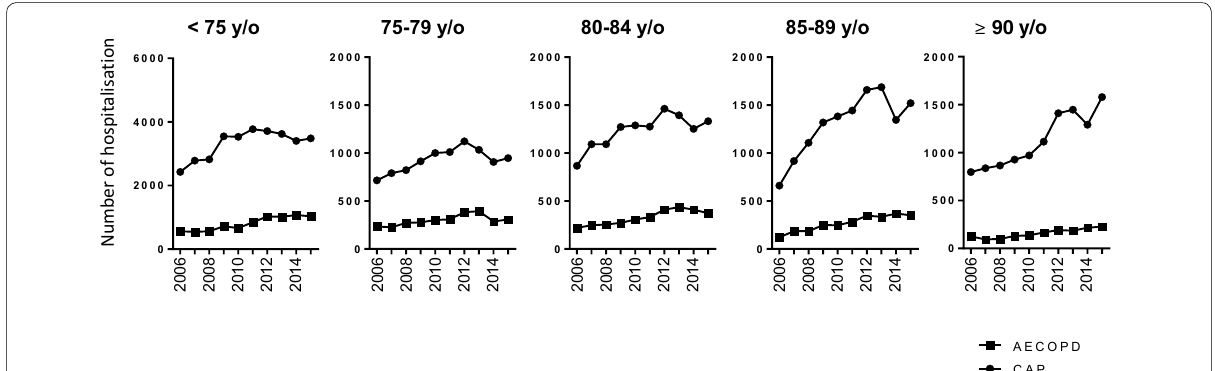
Fig. 3 Ten‑year trends in hospitalisation for CAP and AECOPD by age class. All increases in CAP and AECOPD hospitalisations over time from 2006 to 2015 were statistically significant. AECOPD acute exacerbation of chronic obstructive pulmonary disease; CAP community‑acquired pneumonia